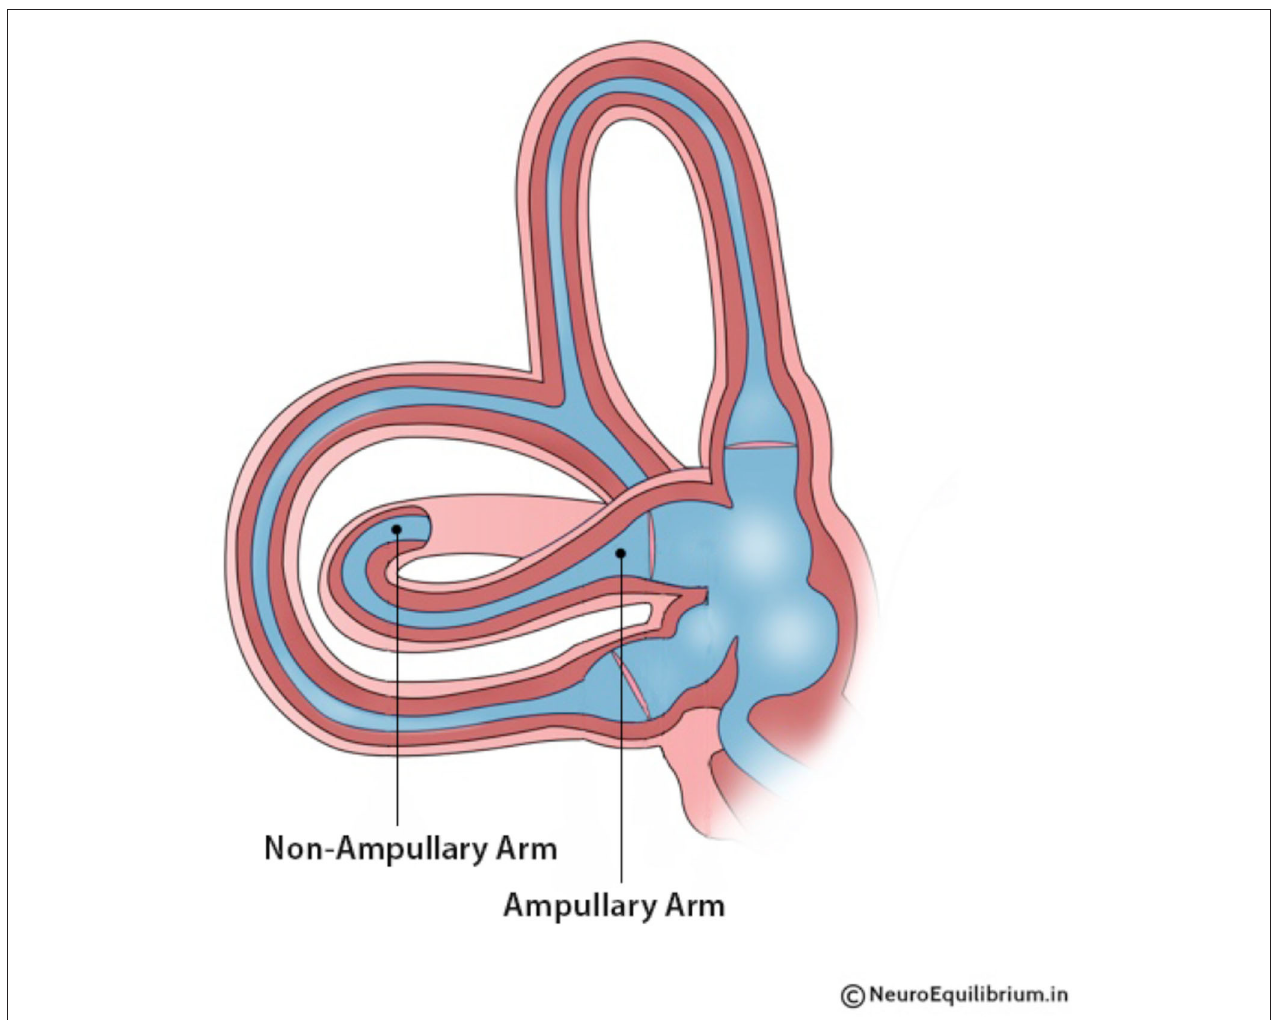
FIGURE 1 | A horizontal canal showing ampullary and non-ampullary